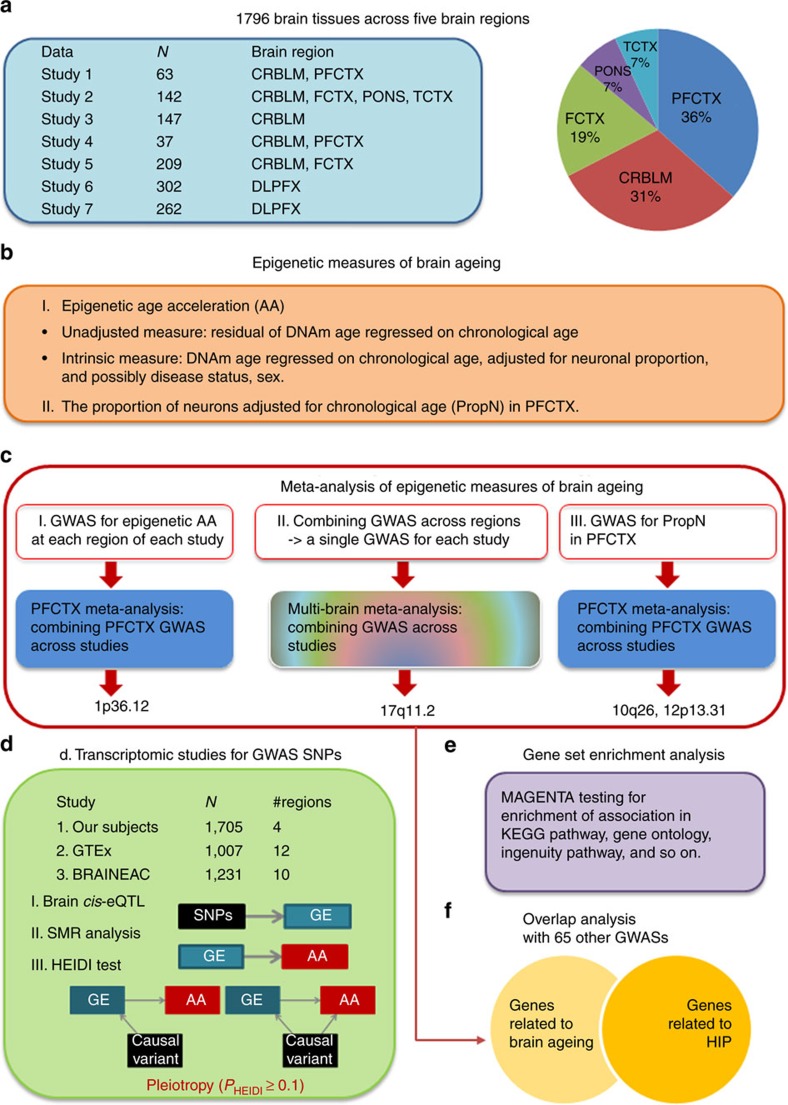
Overview of the analysis that characterized genetic factors underlying epigenetic measures of brain ageing.(a) The study involved SNP data and DNA methylation data from 1,796 brain tissue samples across multiple brain regions: cerebellum (CRBLM), frontal cortex (FCTX), pons (PONS), (dorsal lateral) prefrontal cortex (DLPFX/PFCTX) and temporal cortex (TCTX). (b) Our GWASs involved two DNA methylation-based traits of brain ageing: epigenetic age acceleration (based on the epigenetic clock) and the proportion of neurons (estimated using the CETS algorithm). The (cell-)intrinsic measure of epigenetic age acceleration in brain tissue is defined to be independent of the proportion of neurons. (c) To combine the GWAS results of individual brain regions across seven different studies, we used meta-analysis. (d) To prioritize genes near genome-wide significant loci, we used cis-eQTL studies and Mendelian randomization analyses based on summary test statistics. (e) To identify biological pathways underlying epigenetic measures of brain ageing, we used gene set enrichment analysis. (f) To demonstrate that SNPs associated with brain ageing are often associated with other complex phenotypes, we used a gene overlap analysis with published GWAS results. AA, age acceleration; GE, gene expression; HIP, hip circumference; SMR, summary data-based Mendelian randomization.